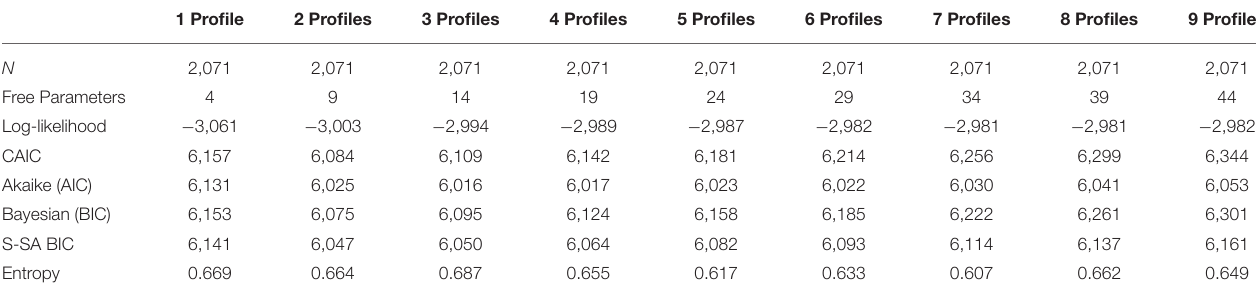
TABLE 4 | Multi-level LPA fit statistics.